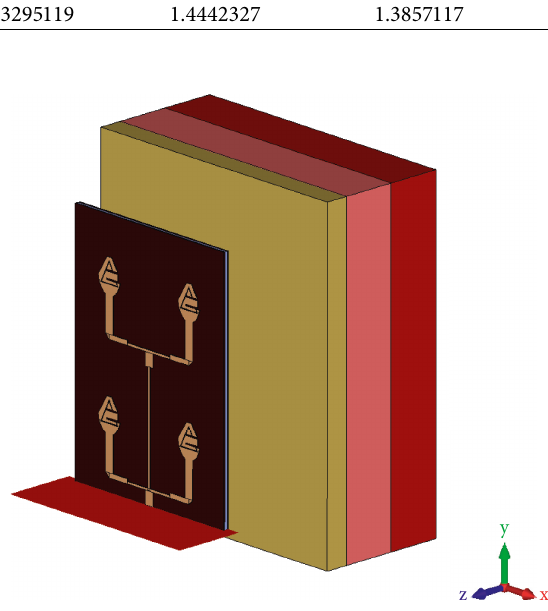
Figure 47: On-body simulation setup for 2 × 2 antenna array.